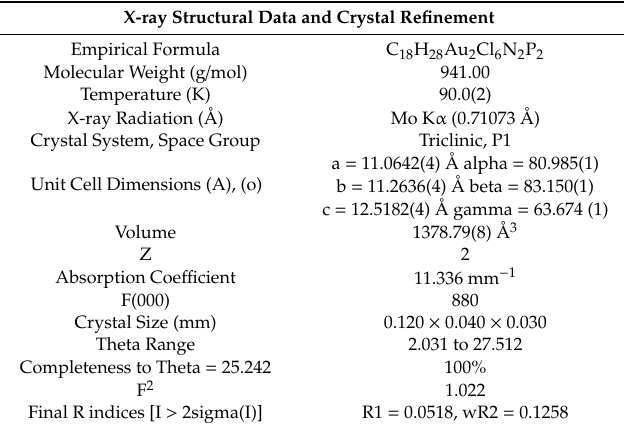
Table 2. X-ray Parameters of 2